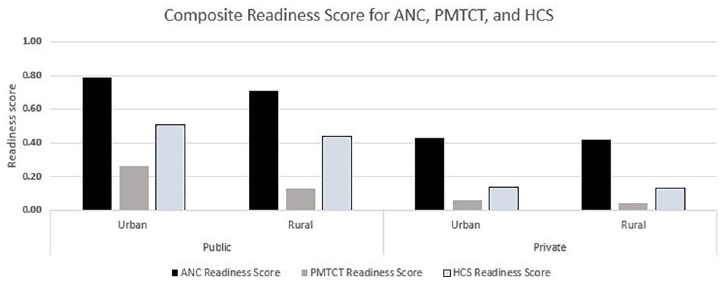
Fig 3. Composite readiness scores for ANC, PMTCT and HCS, by urban/rural and public/private, 2016. Note: ANC: antenatal care; PMTCT: Prevention of Mother-to-Child Transmission; HCS: HIV care and support. Four variables in ANC service indicators were excluded since the comparable variables were not available for private facilities–these are guidelines and staff trained in ANC, and the availability of folic acid tablets and tetanus toxoid